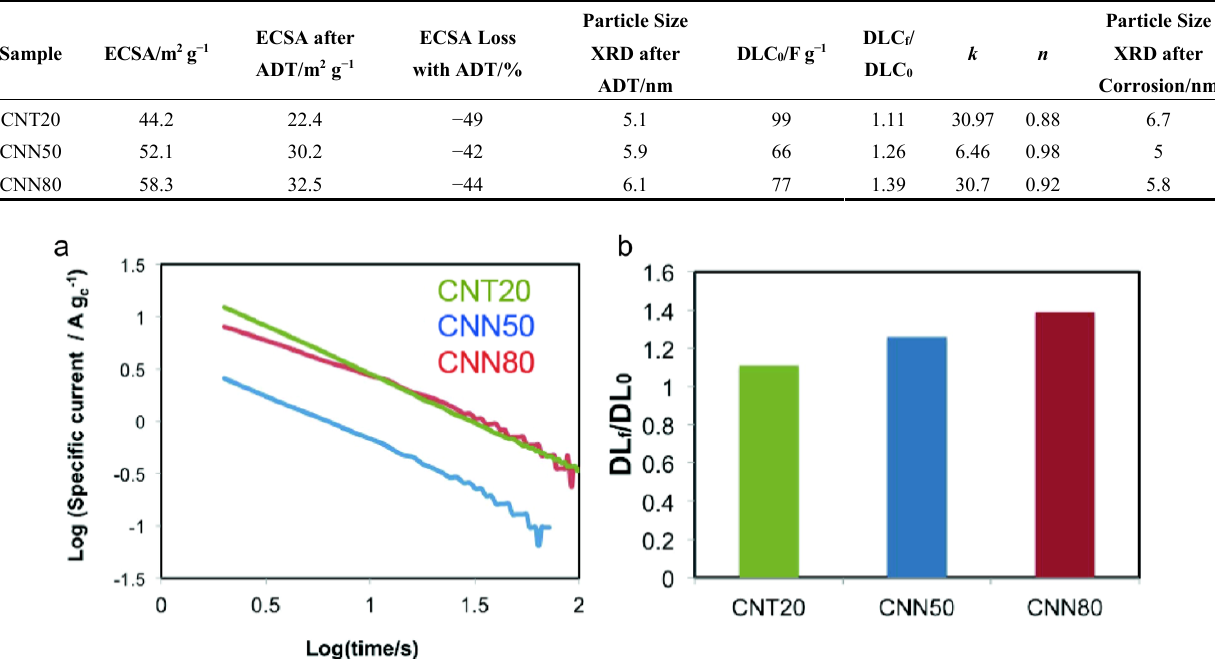
Figure 6. ( a ) Current density–time curves of carbon samples corrosion in double logarithmic scales, performed in half-cell at 1.4 V vs. RHE, fed with nitrogen and at room temperature; ( b ) Ratio of the double layer capacitance before and after and corrosion for the